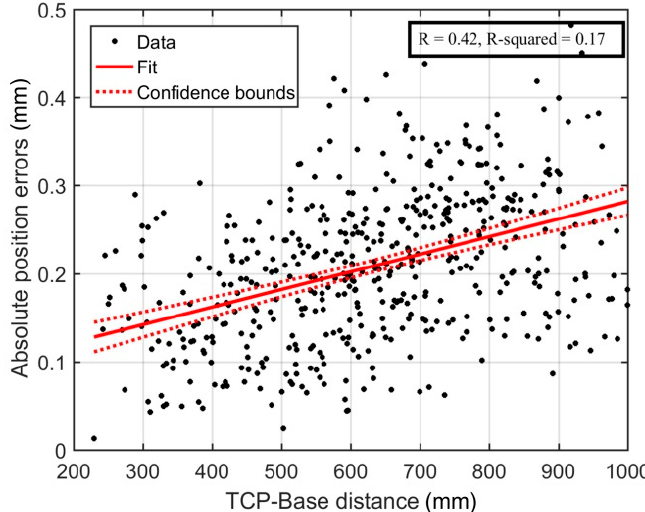
Figure 11. Linear regression-Distance between the TCP and the origin of the base frame.